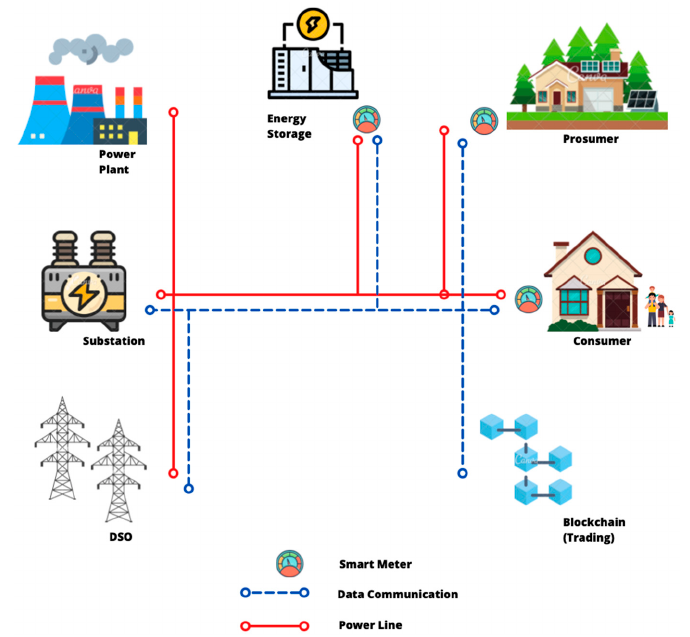
Figure 1. Energy trading system concept.